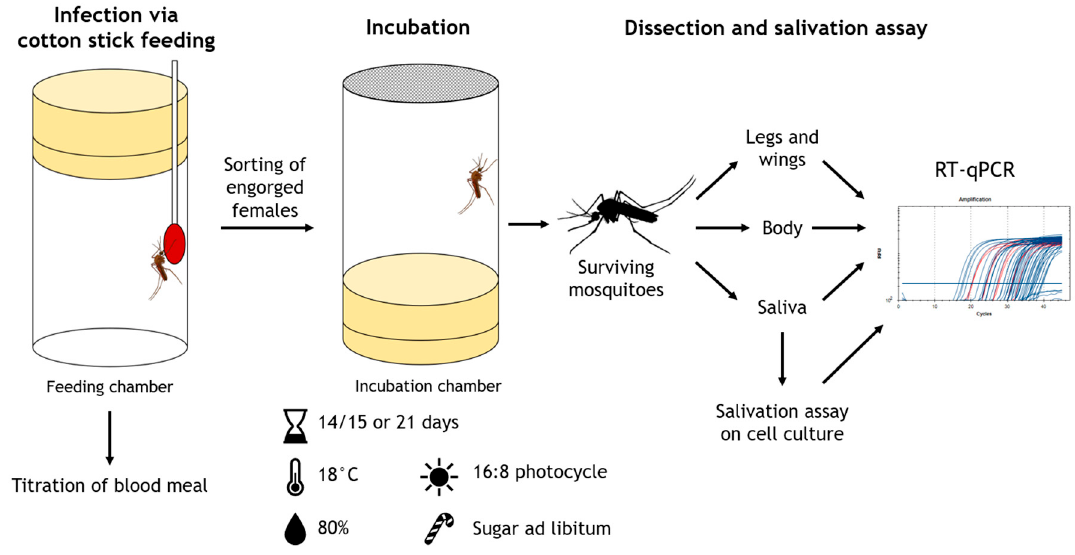
Figure 2. Procedure of vector competence trials.